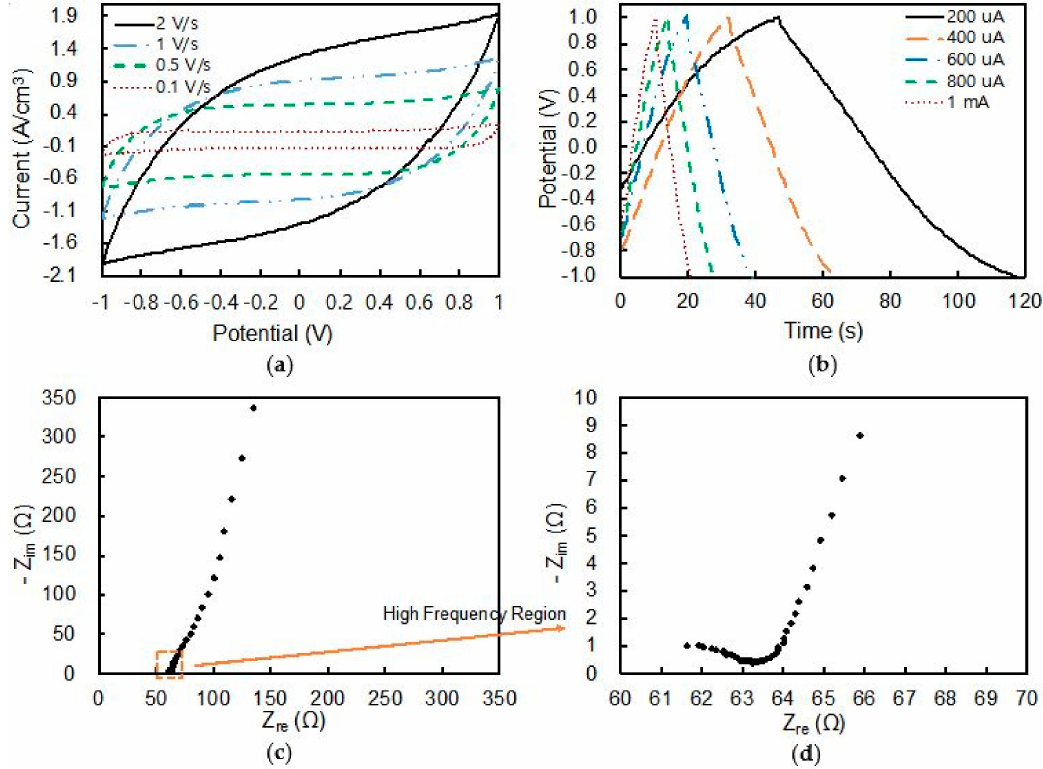
Figure 12. ( a ) CV curve of fiber-shaped supercapacitor at 0.1 V s − 1 –2 V s − 1 scan rate; ( b ) GCD curve of the nanostructured electrodes at 200 µ A–2 mA charging and discharging currents; ( c ) and ( d ) EIS of the nanostructured electrodes at 100 kHz–0.01 Hz under 2